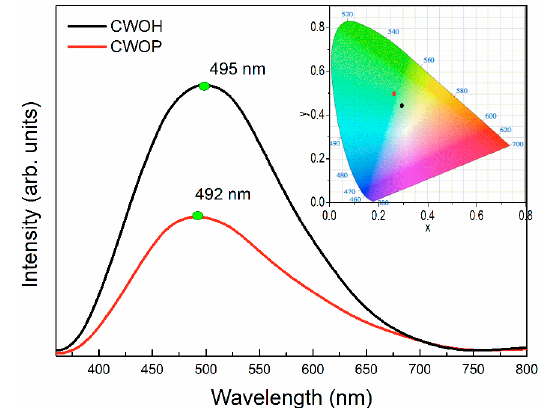
adsorption-desorption isotherms of CaWO Figure 3. The N 2 synthesized by PPM and MAH